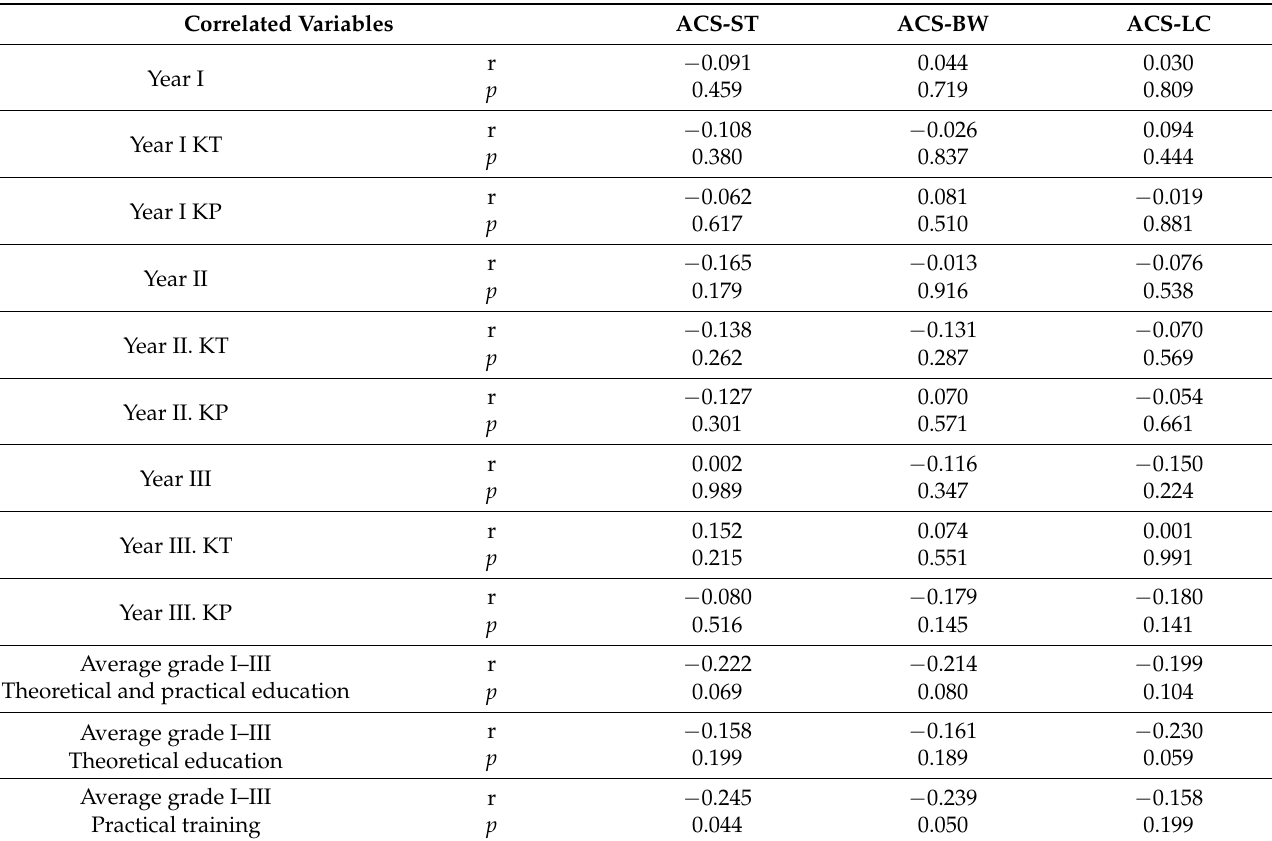
Table 4. Spearman’s rank correlation coefficient between the development of nursing competences and school grades obtained by students after the first, second, and third year of the study, and average grade during three-year cycle of